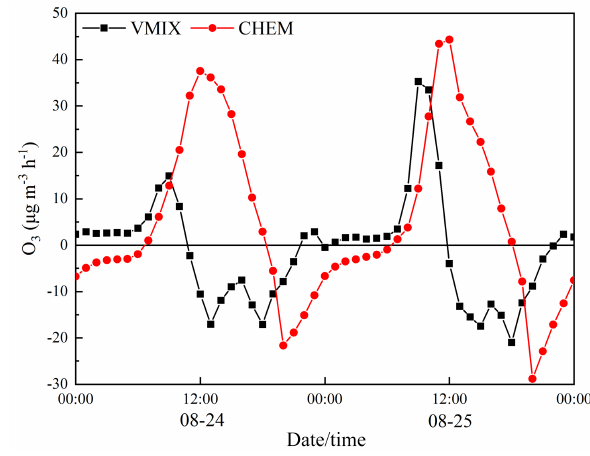
Figure 7. The contribution rates of vertical mixing (VMIX) and chemical reactions (CHEM) to surface O 3 concentrations at the NJ site during the 24–25 August 2016 period.